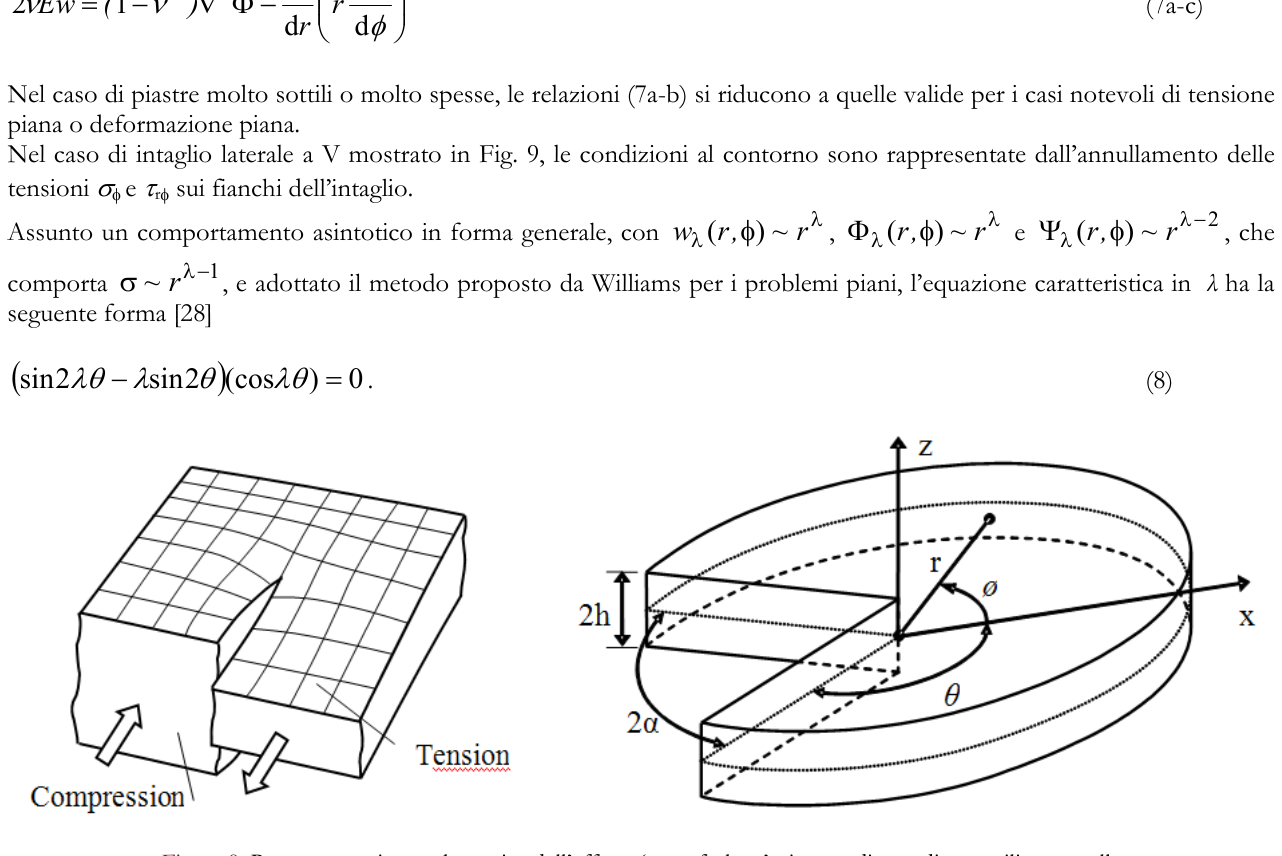
Figura 9: Rappresentazione schematica dell’effetto ‘out-of-plane’; sistema di coordinate utilizzato nella trattazione analitica (simbologia in accordo con le referenze